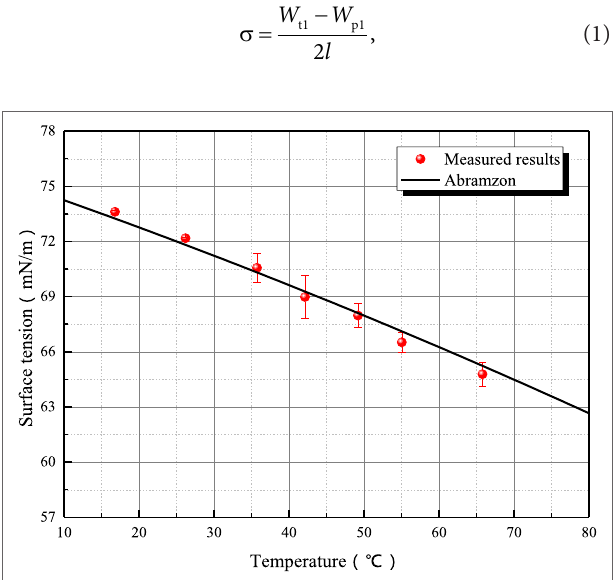
FigUre 1 | The precision verification for surface tension of distilled water.